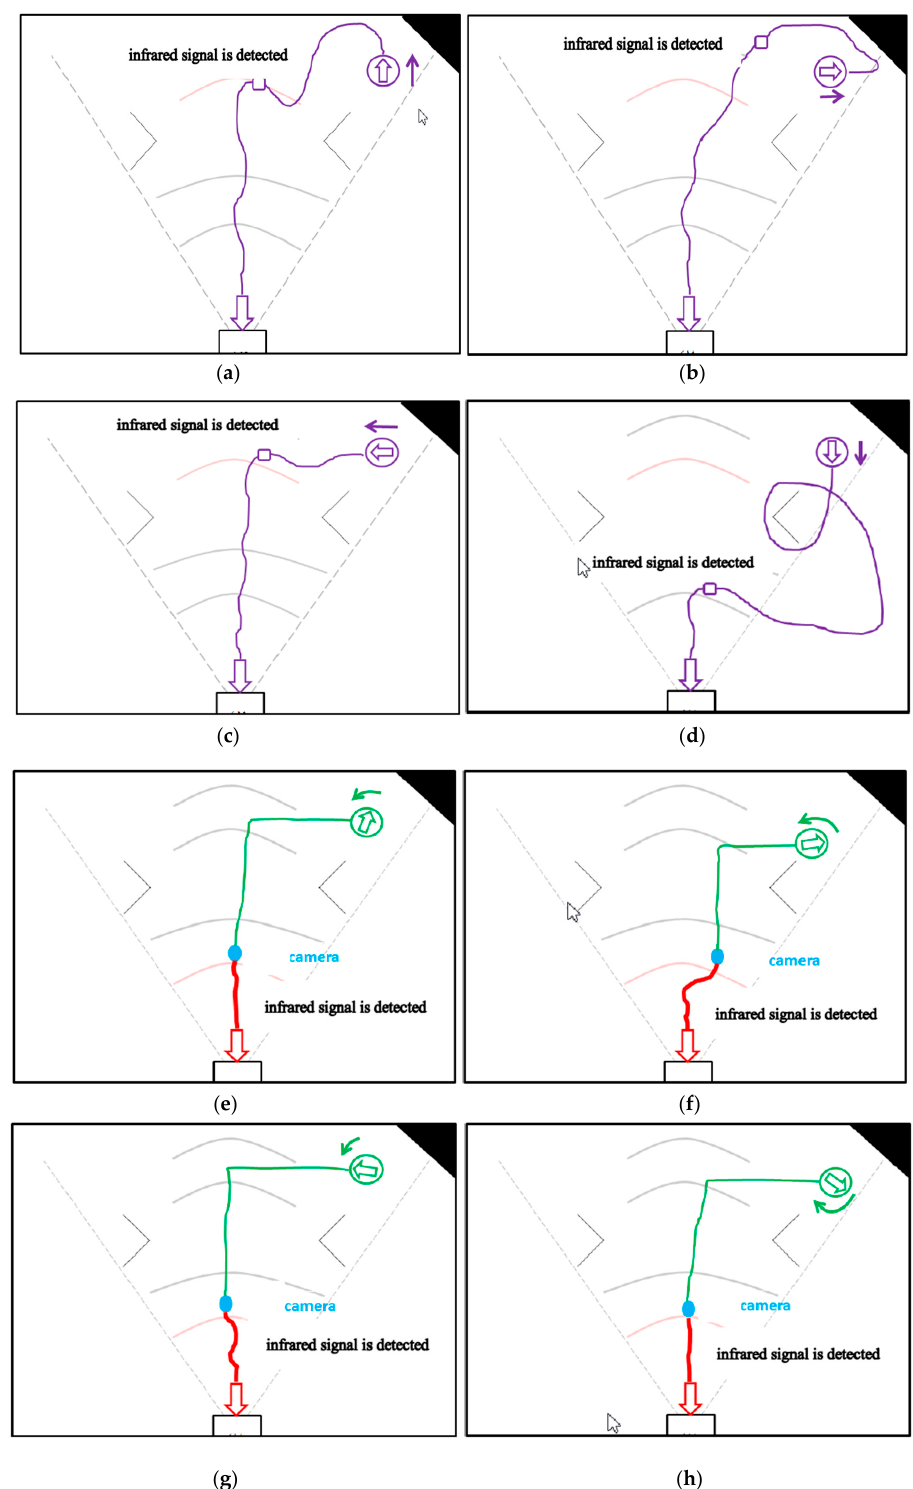
Figure 22. Second part of experiment: the cleaning robot is placed inside the range of the infrared signal emitted by the infrared sensor of the docking station to back to charging by general-type and the proposed mechanisms. ( a ) In the general-type mechanism, robot facing up bypasses until